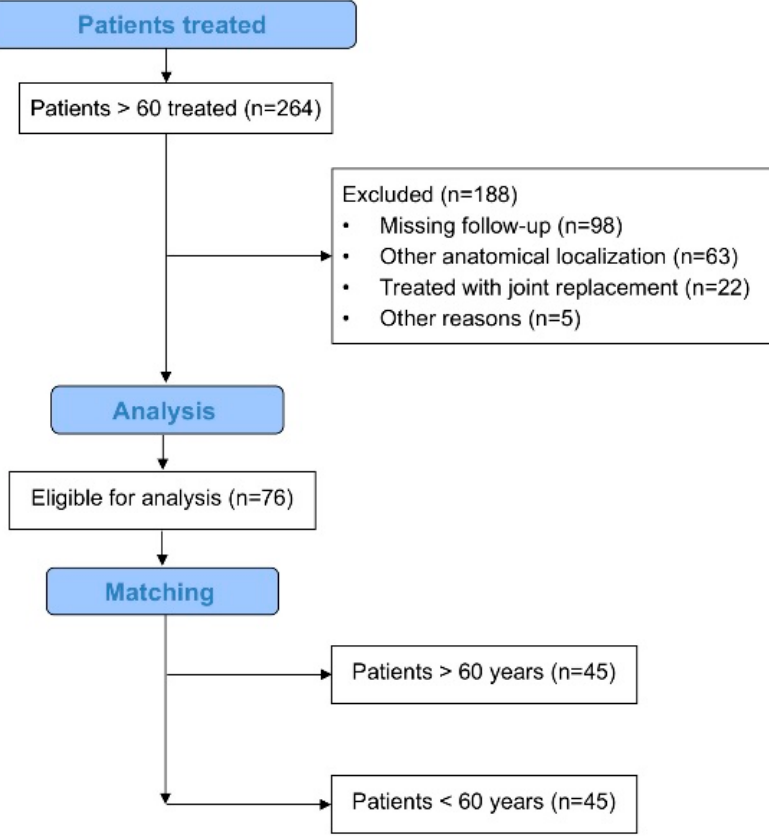
Figure 1. Flow chart visualizing the patient selection process. Table 1. Patient characteristics.